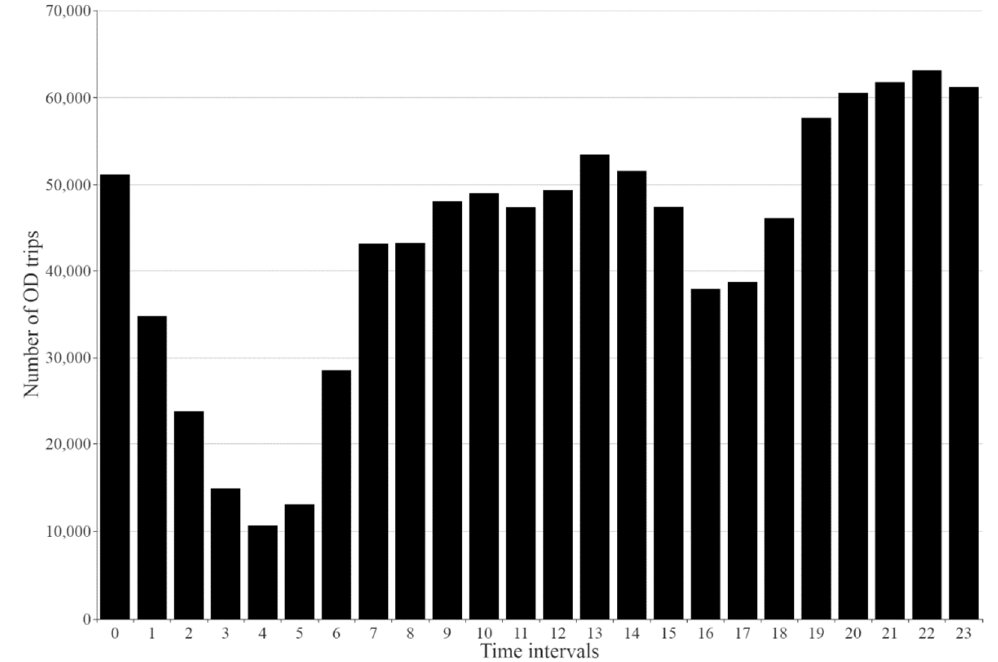
Figure 5. Temporal distribution of Origin-Destination (OD) trips.